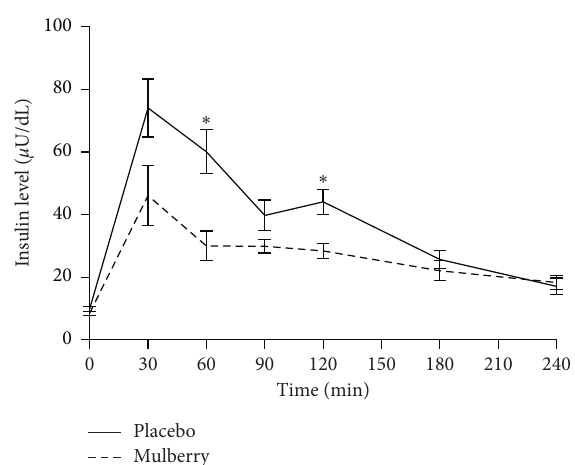
Figure 2: Blood insulin level after consuming two jelly samples (placebo and MFP jelly), data expressed as mean ± SE. ∗ Statistically significant ( p value < 0.05).